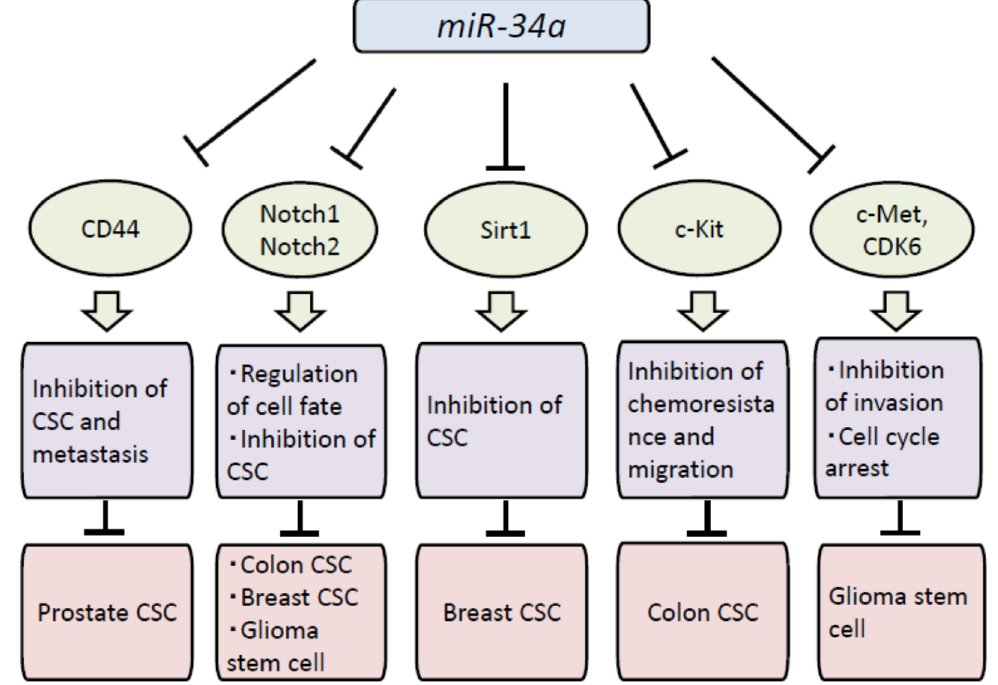
Figure 2. Biological effects of miR-34a in CSCs. The direct targets and biological effects of miR-34a in various CSCs are summarized; CSC; cancer stem